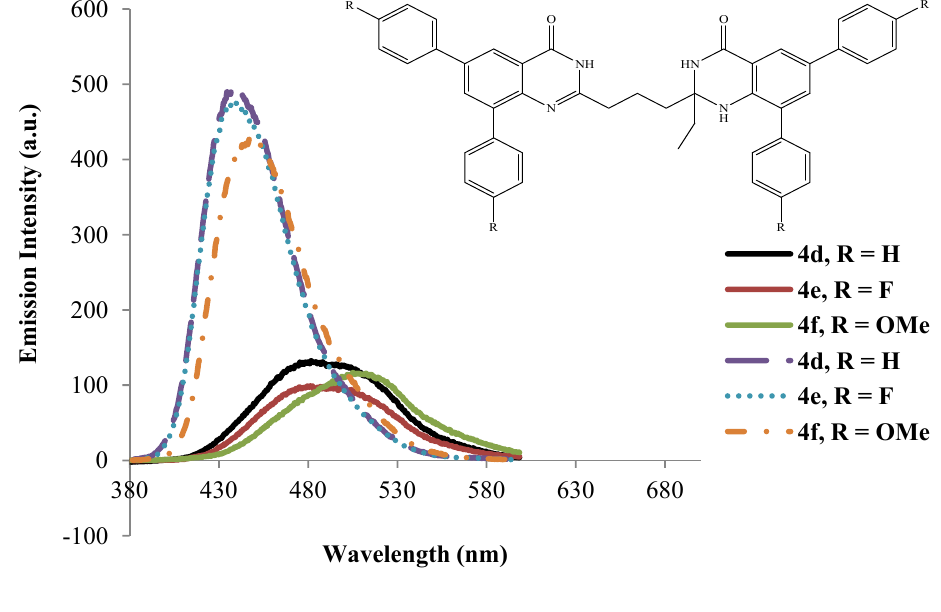
Figure 7. Emission spectra of 4d – f ( λ (solid lines) at rt (conc. = 1.0 × 10 − 4